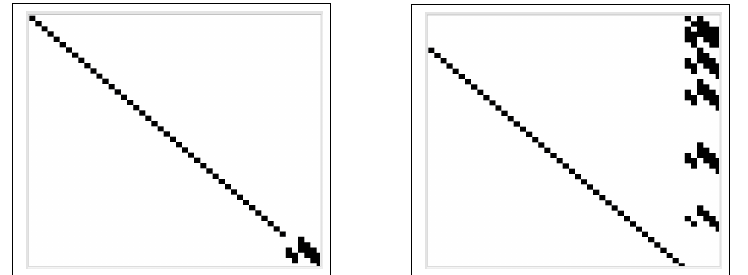
Figure 5. Shape of pencil of